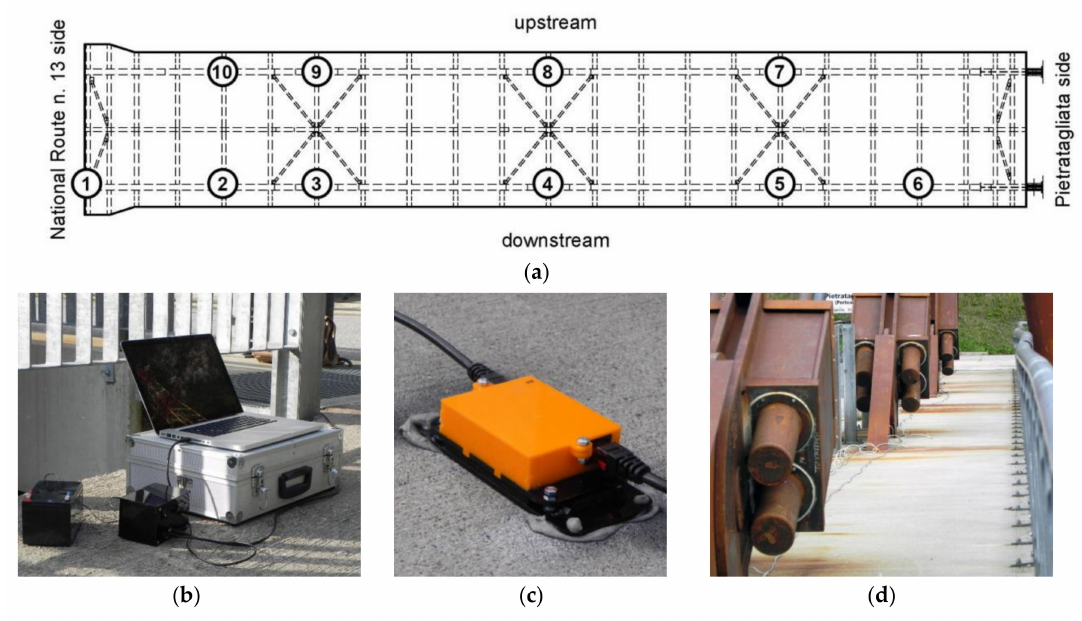
Figure 6. Experimental testing on the Pietratagliata bridge. ( a ) test setup (top view of the steel-concrete composite slab (dimensions in meters); in the circles, the instruments labels) and ( b – d ) instrumentation